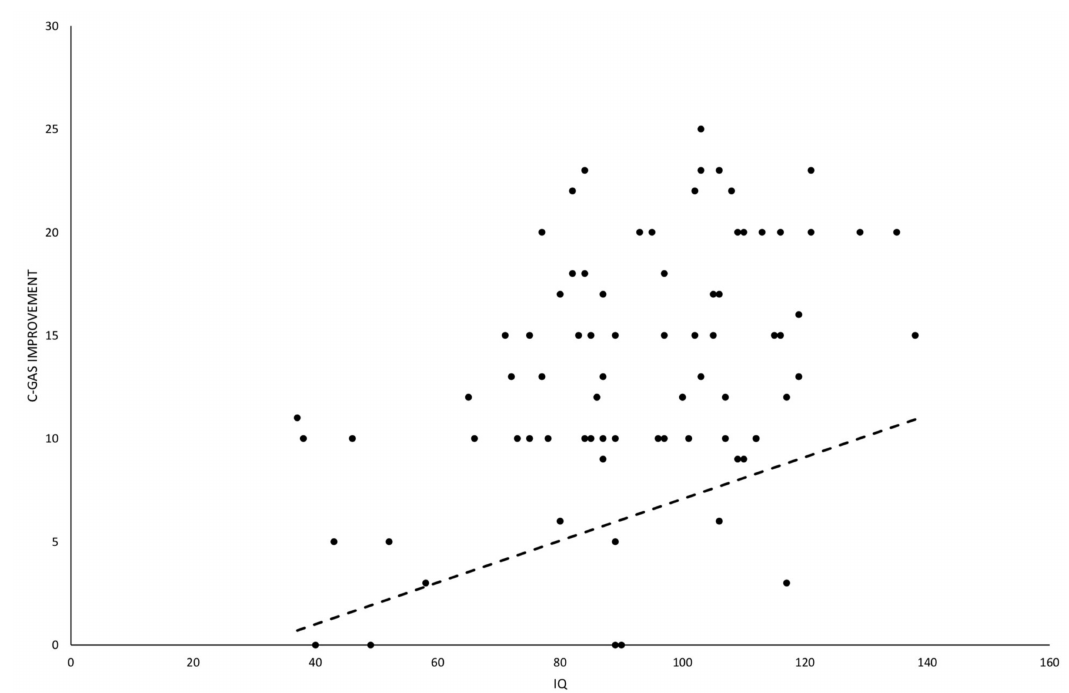
Figure 3. Scatter plot to evaluate relationship between C-GAS improvement and IQ. This factor resulted statistically significant in the multivariable model. The line is drawn with the slope (b = 0.1, p = 0.0003) estimated in the multivariable model and other variables set at their mean